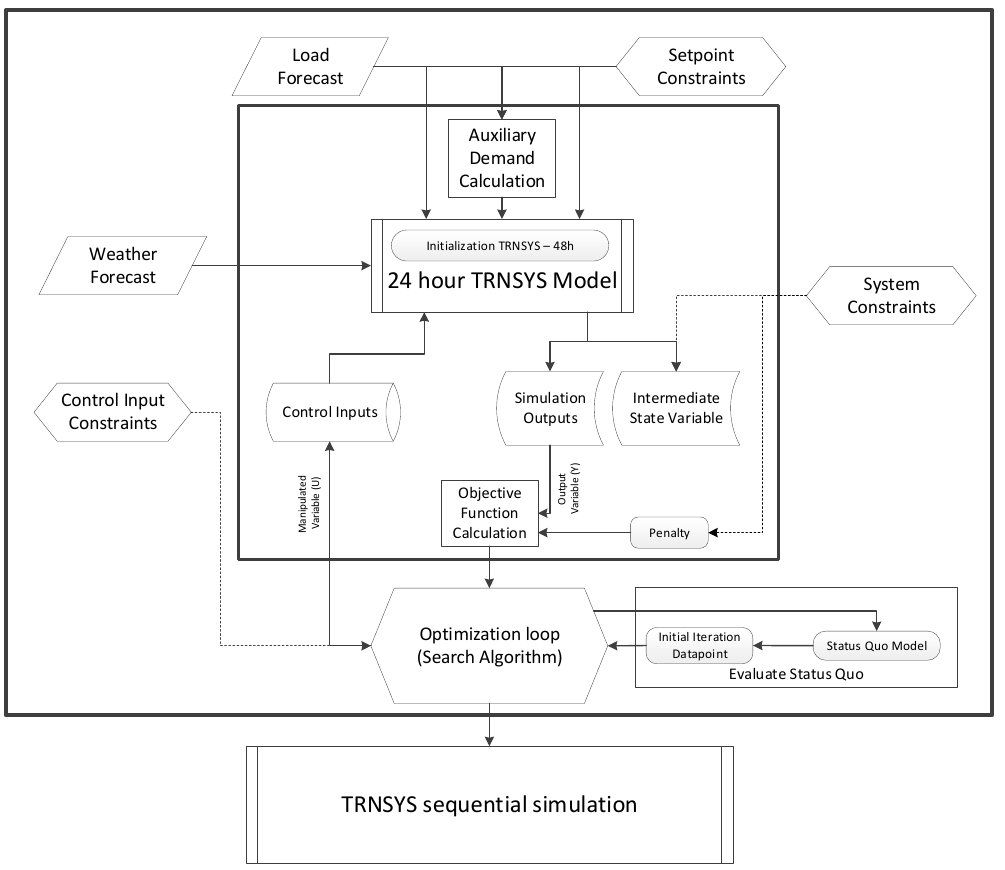
Figure 6. Simulation framework of the coupled TRNSYS-MATLAB Building-HVAC MPC.